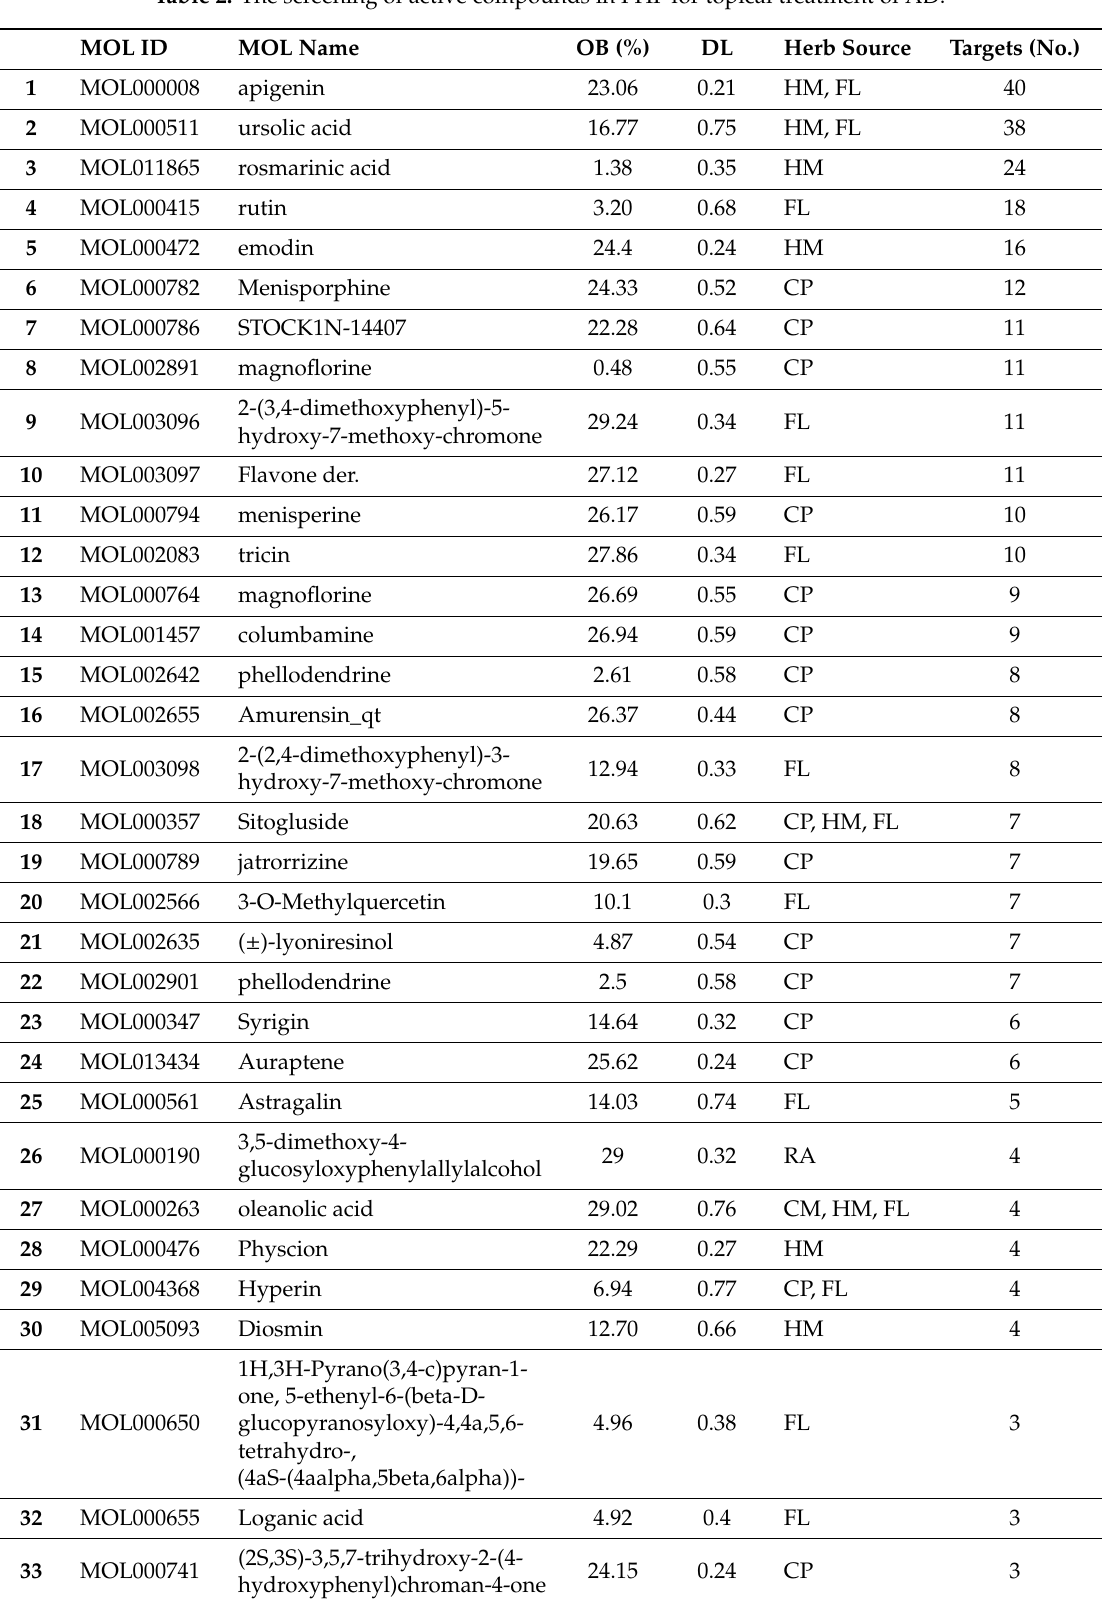
Table 2. The screening of active compounds in PHF for topical treatment of